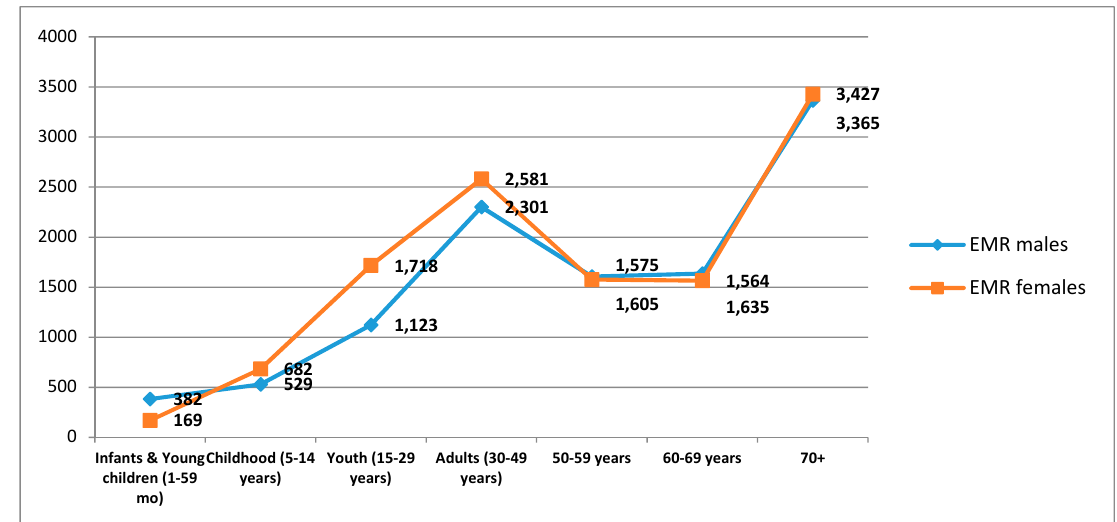
Figure 1. Trends in total deaths (Y axis) from Rheumatic Heart Disease by age and sex in the Eastern Mediterraenan Region (EMR).